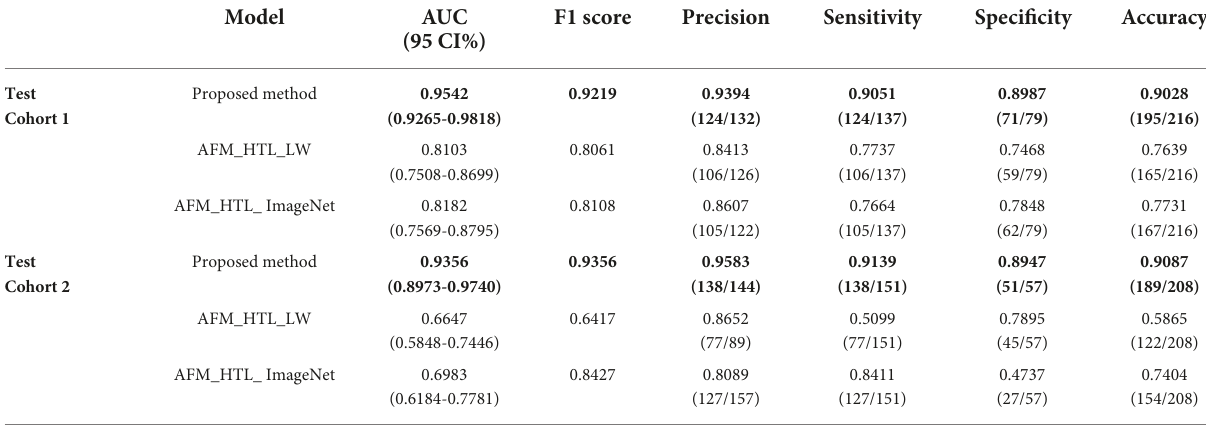
TABLE 3 The performance indices of the proposed method and transfer learning models based on different source domains.